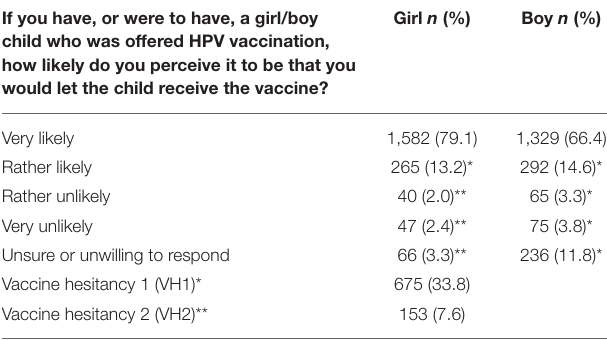
TABLE 2 | Attitudes toward the HPV